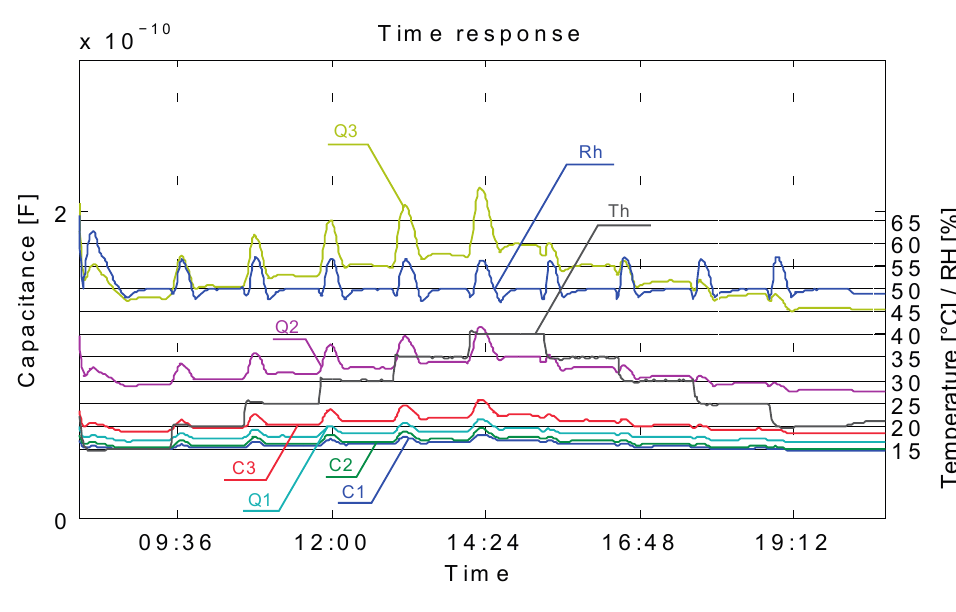
Figure 14. Printed sensor response with temperature.